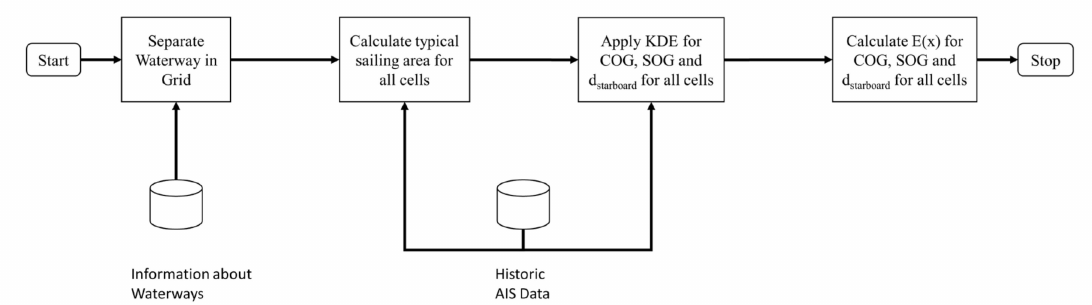
Figure 2. Extraction process of vessel tra ffi c patterns within a given waterway. This process concludes with the calculation of the expected value for the considered parameters. COG, Course Over Ground; SOG, Speed Over Ground and distance to the starboard side of the waterway (d starboard